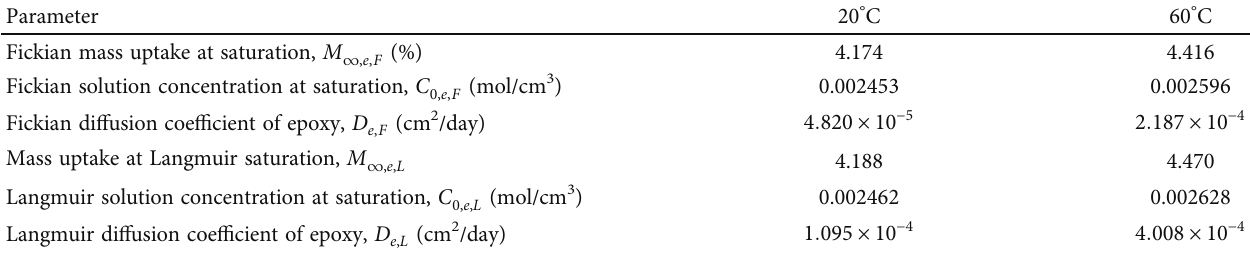
Table 3: Epoxy thin fi lm Fickian and Langmuir di ff usion parameters at 20 ° C and 60 ° C. Parameter